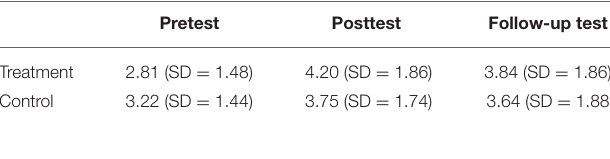
TABLE 1 | Average test scores of the treatment and control group.